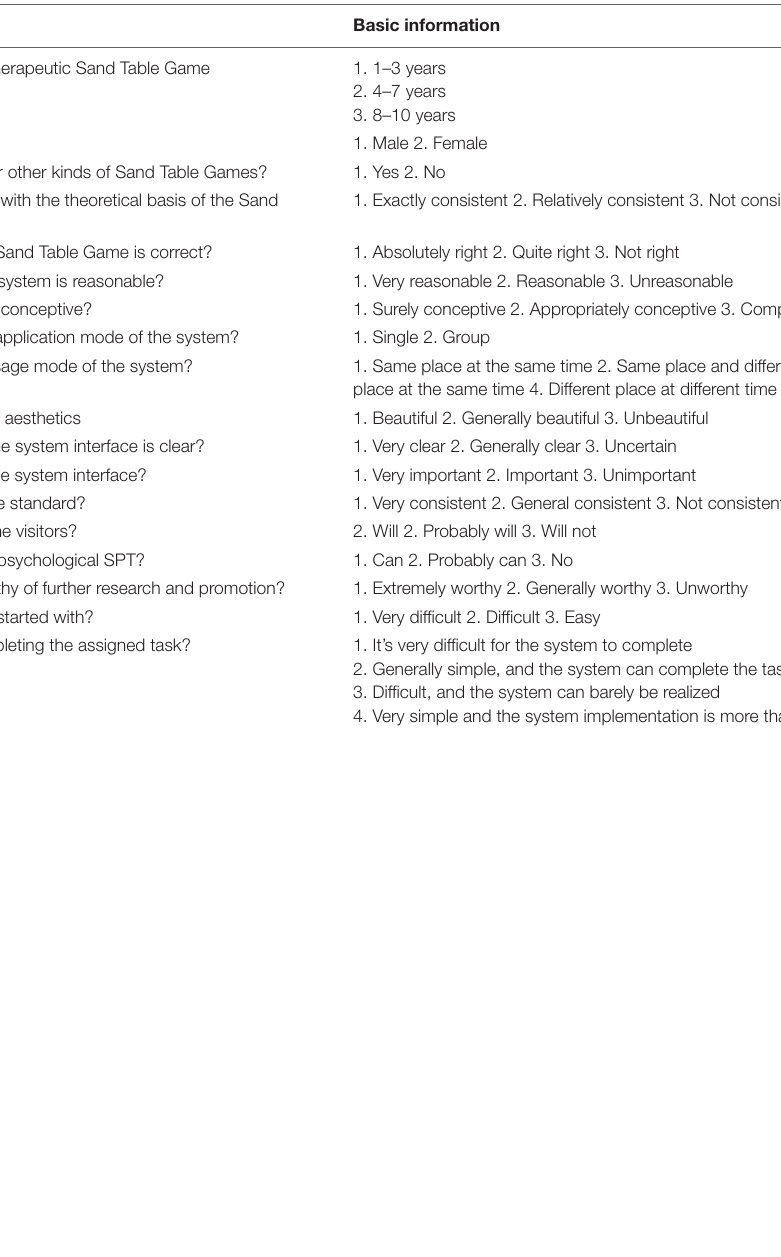
TABLE A1 | Sand table game mental health